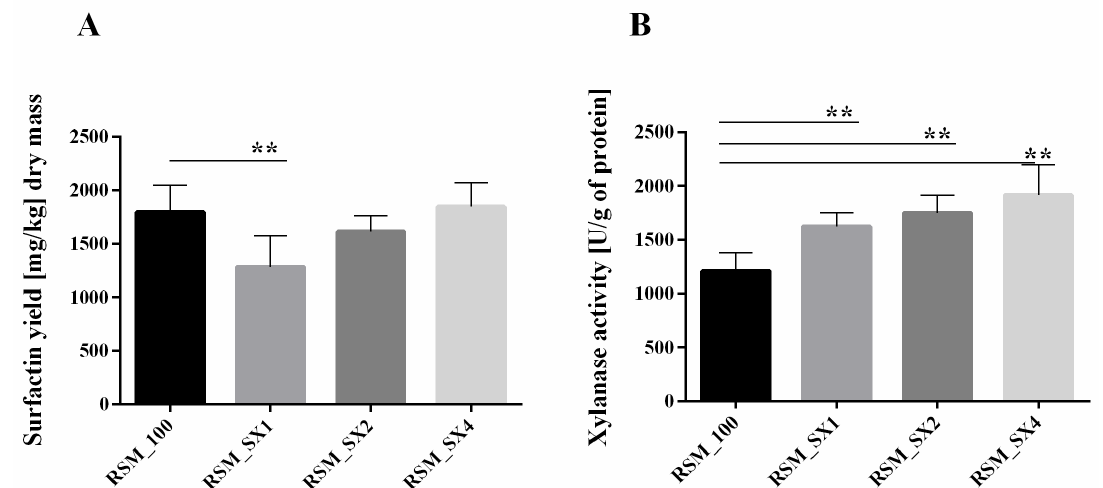
Figure 3. Surfactin yield ( A ) and general xylanase activity ( B ) obtained by B. subtilis 87Y during 24 h SSF on RSM with sucrose and xylan as carbon sources. SX1, 2, 4—sucrose addition in 60 g/L, xylan addition in 10, 20, or 40 g/L. Statistical significance in all cases is presented as follows: ** p <0 .01